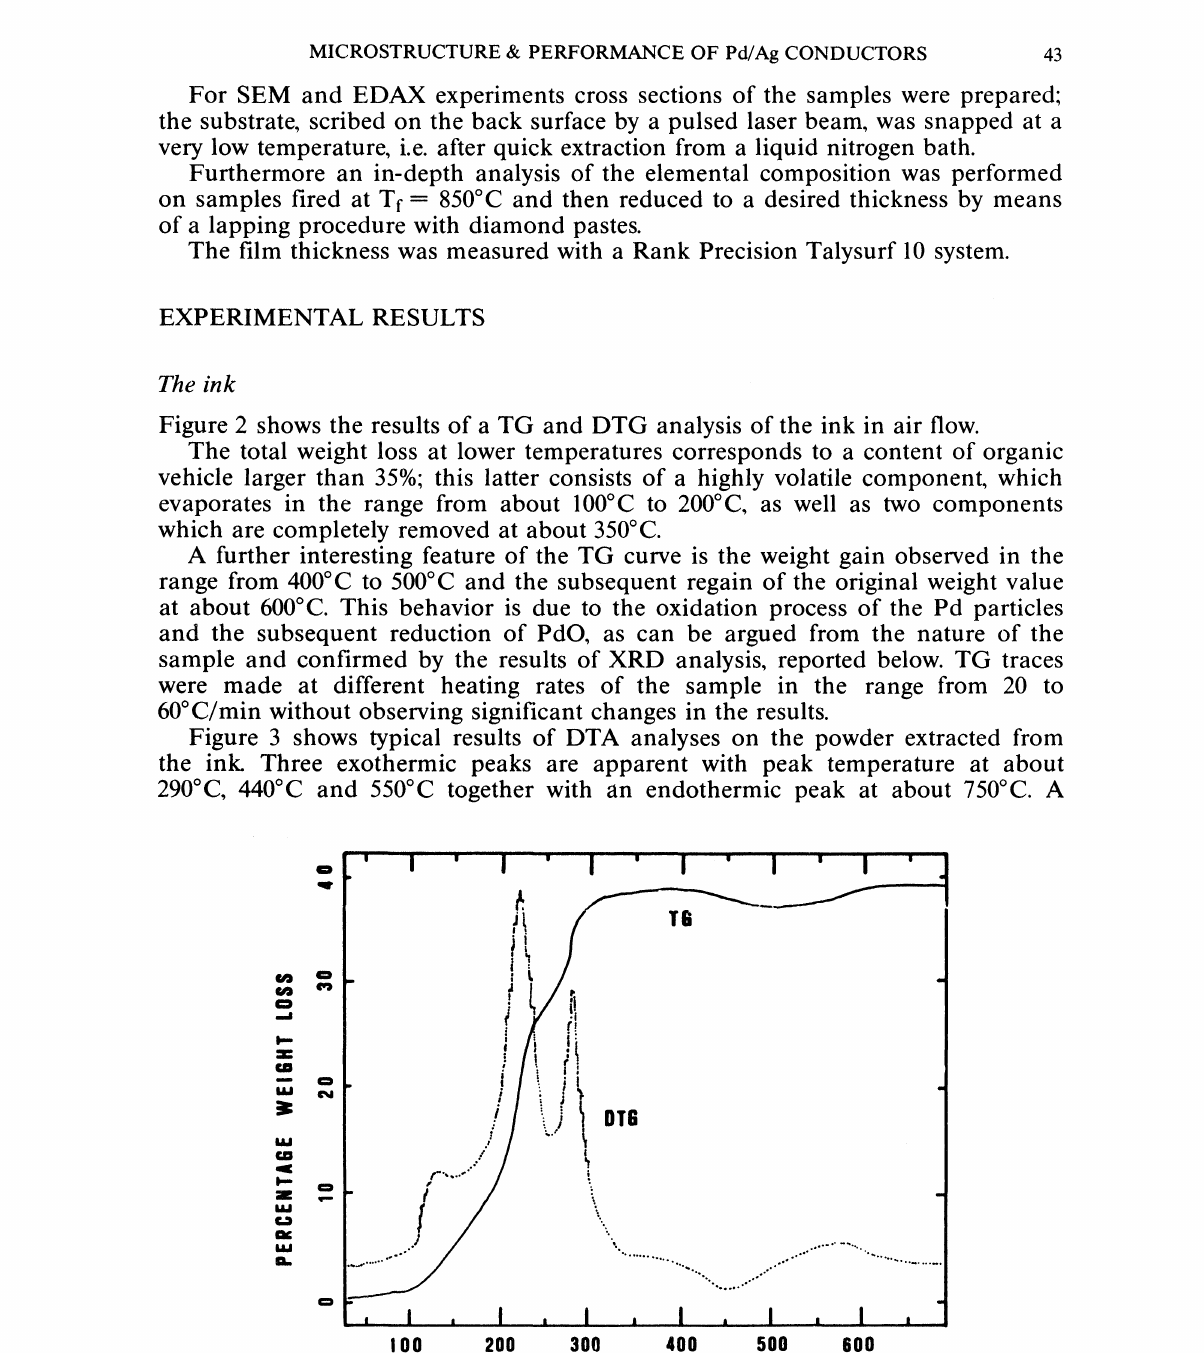
FIGURE 2 TG curve (continuous line) and its derivative (broken line) ofthe ink. Note the weight loss due to evaporation and burnout of the organic vehicle and the gain in weight due to an oxidation